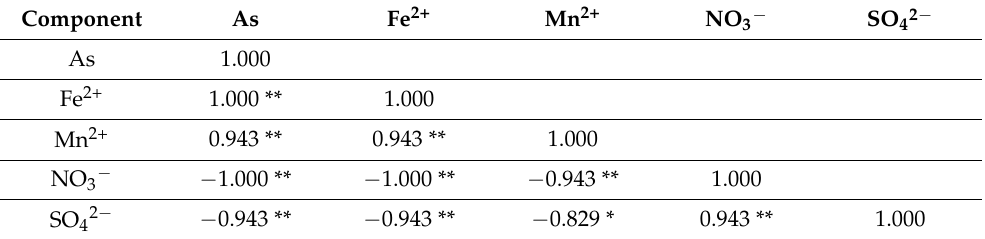
Table 2. Correlations between As, Fe 2+ , Mn 2+ , nitrate and sulfate.